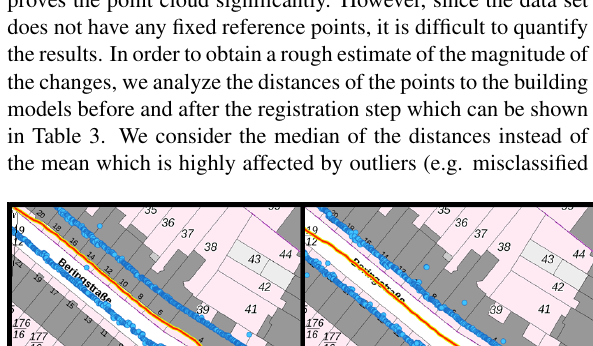
Figure 7. A code-based solution with an accuracy of several me- ters before the application of our method (left). An offset is no- ticed driving past the same building during the outward (green) and return (red) journey. The incorporation of 3D city models in our approach improves the point cloud accuracy (right).